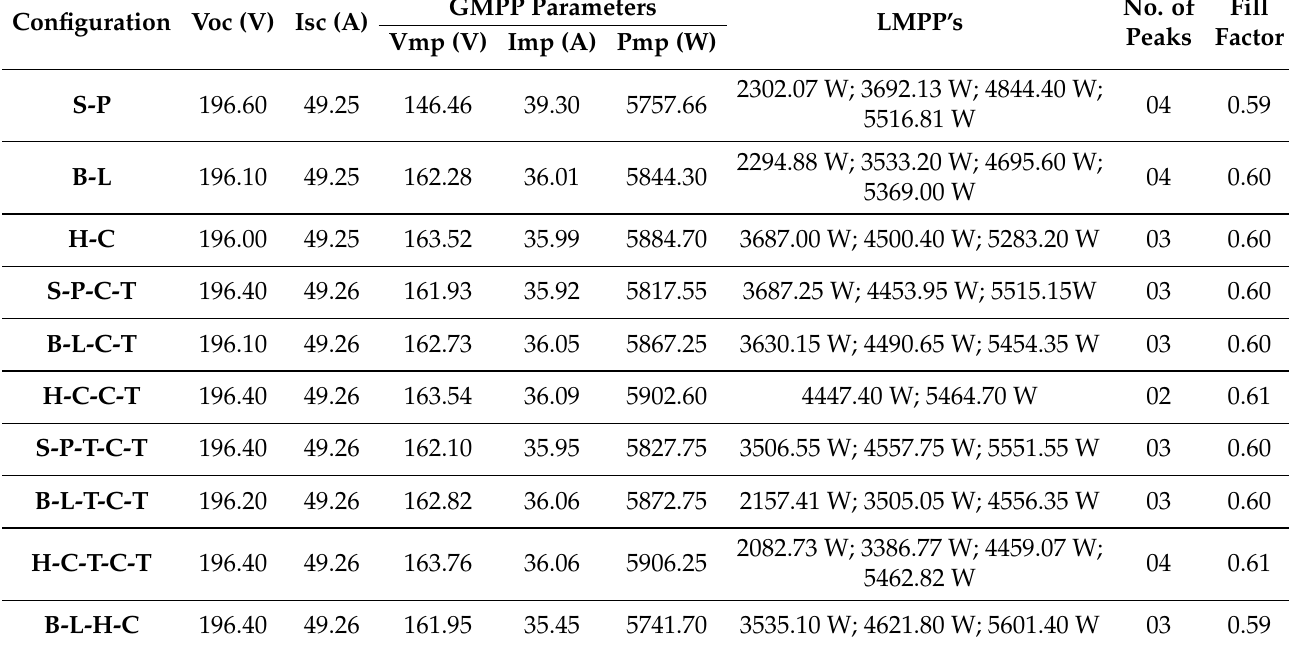
Table 10. Parameter variations of conventional and hybrid configurations under center shading